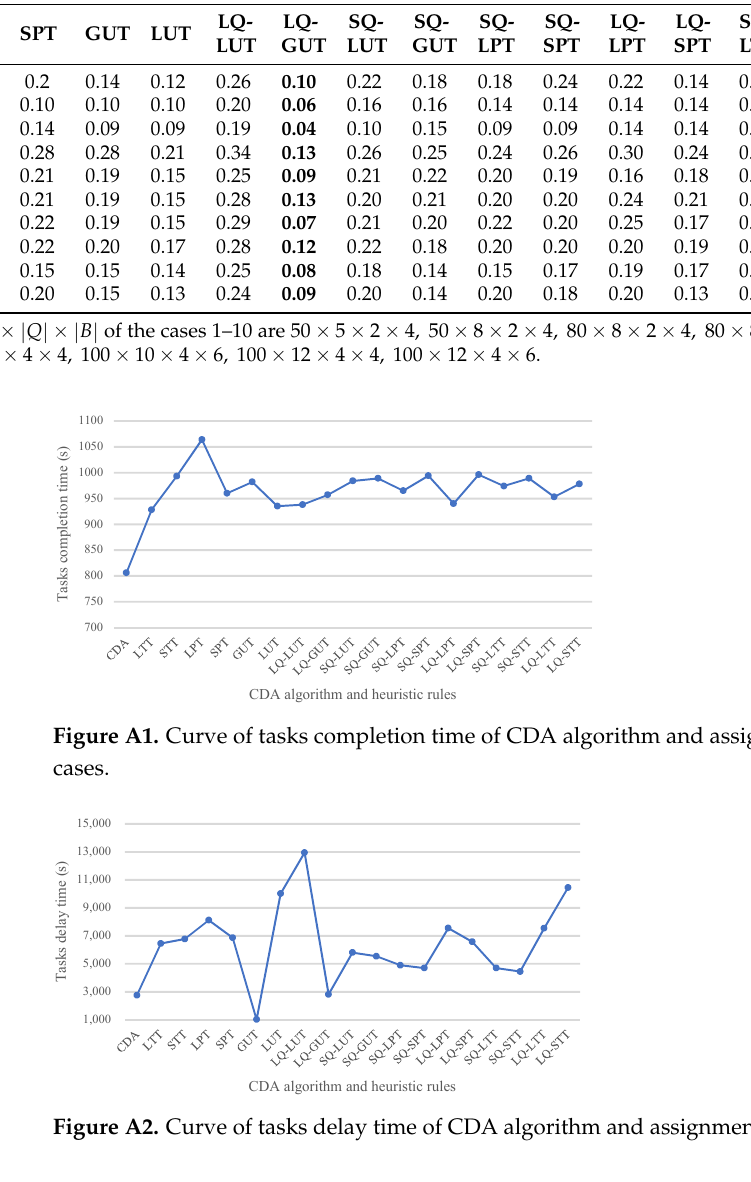
Figure A3. Curve of AGVs travel time of CDA algorithm and assignment rules under different cases.